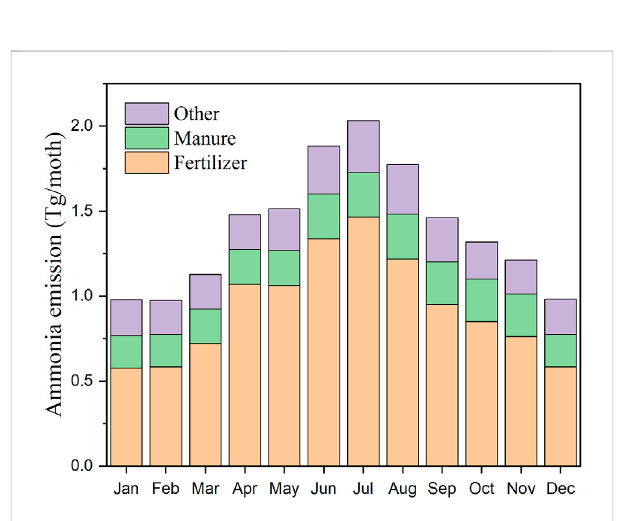
The seasonal pattern of major emission sources in China (Tg/ month). (The data source is only from REAS because fertilizer and livestock manure are merged as agriculture in other